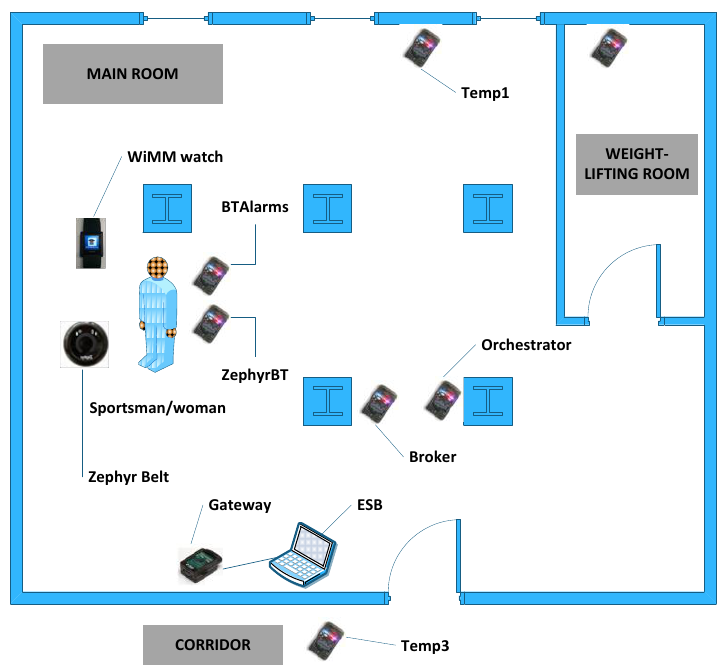
Figure 20. Gymnasium deployment of the